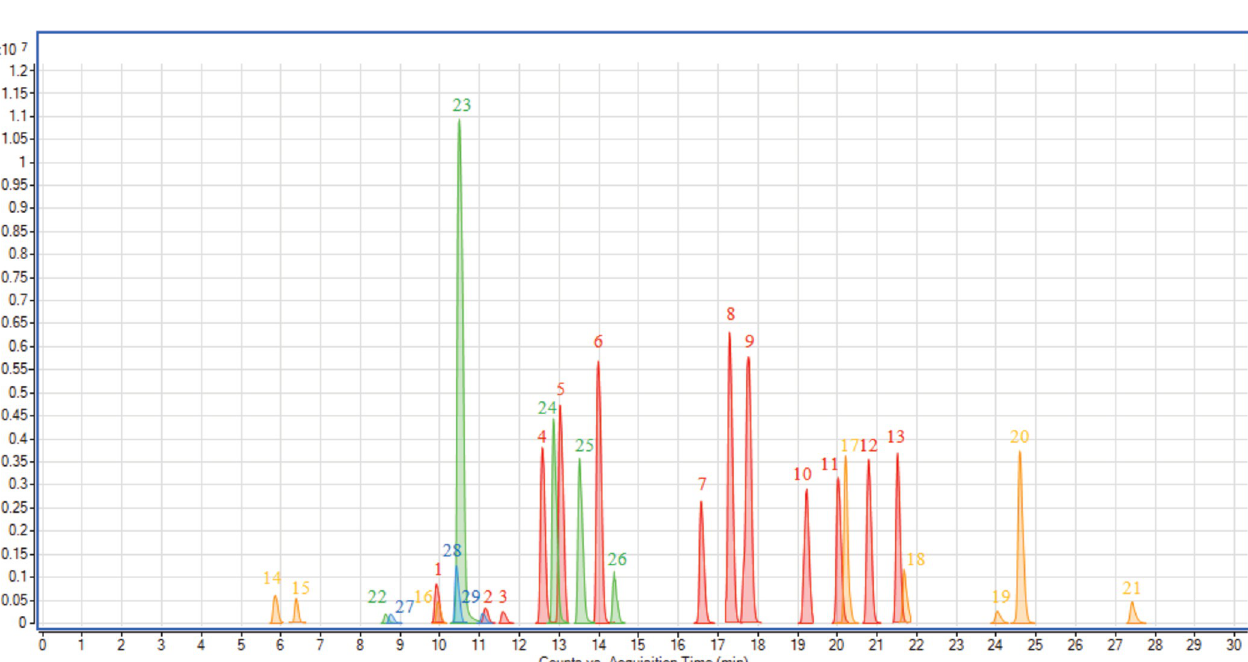
Fig 2. LC–QTOF extracted ion chromatogram of 29 metabolomic oils markers. Sunflower–red, rapeseed–yellow, sesame–green, flax–blue. The number of analytes corresponds to those given in Table 1.